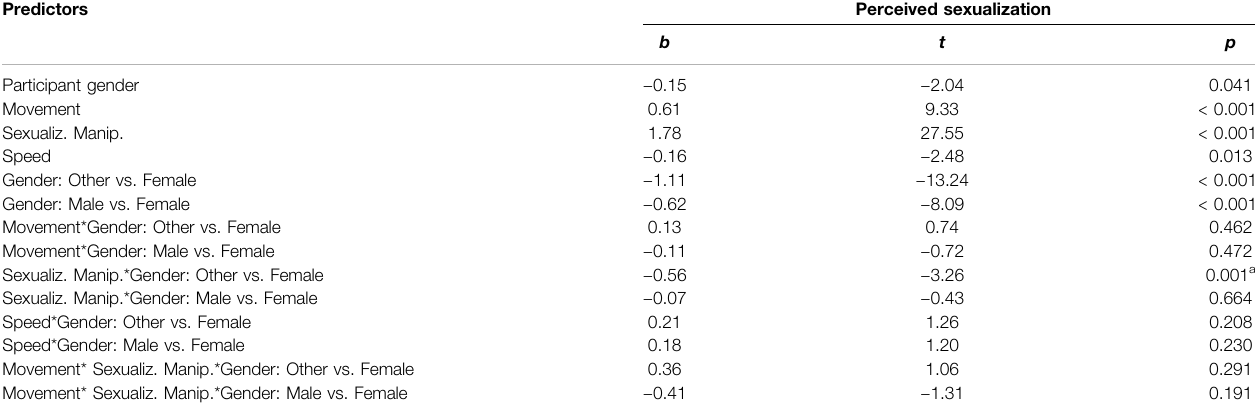
TABLE 7 | Mixed linear model for predicting perceived sexualization by conditions and gender attributed to the point-light display. Predictors Perceived sexualization